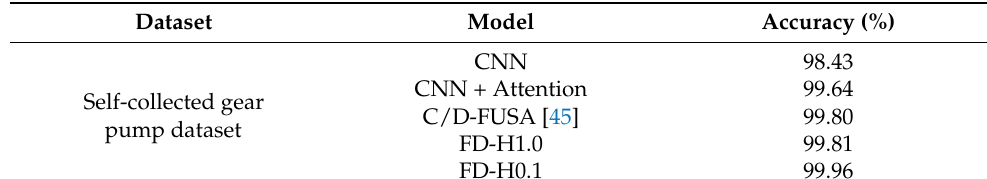
Table 4. Comparison of experimental results for internal gear pumps.